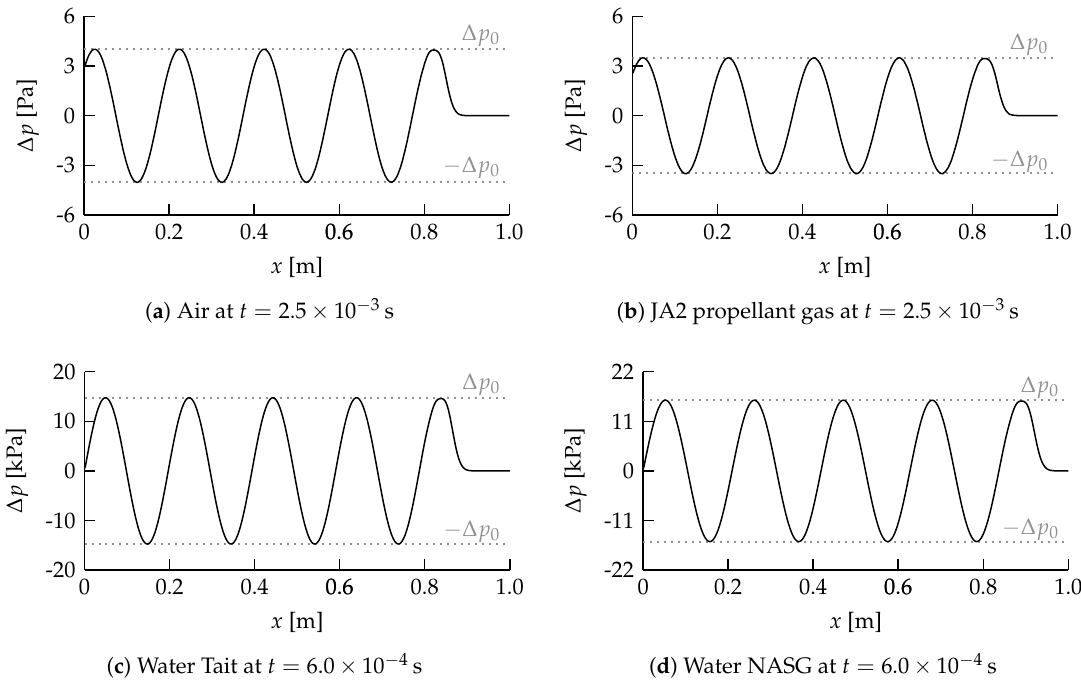
Figure 2. Pressure profiles of acoustic waves in different fluids obtained using the proposed algorithm. The pressure amplitudes based on linear acoustic theory, ± ∆ p 0 , are shown as a